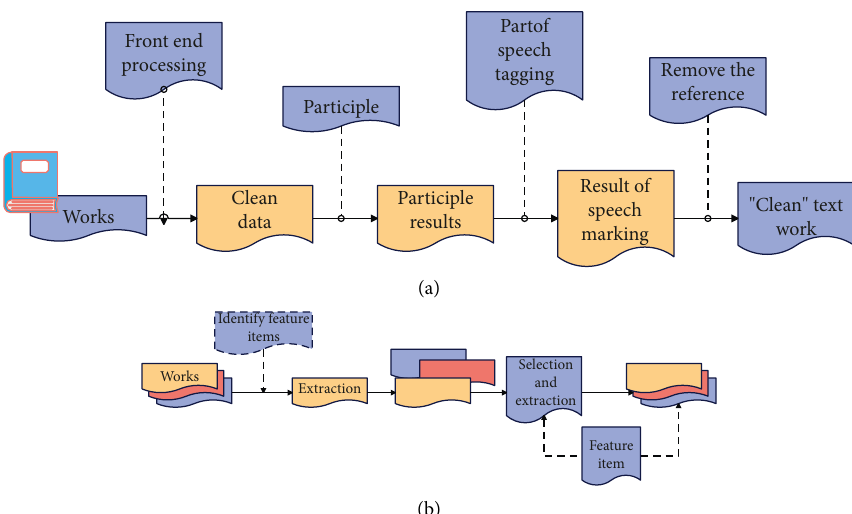
Figure 3: Semantic feature extraction of English writing text. (a) English writing text preprocessing process. (b) The process of extracting and selecting semantic features of English writing texts.